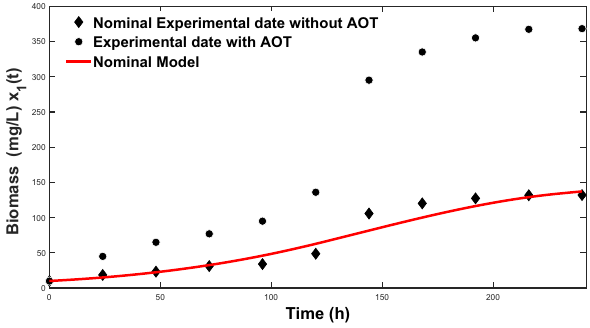
Figure 3: Comparison of biomass with/without AOT recovered sub - strate feedback and the nominal model.